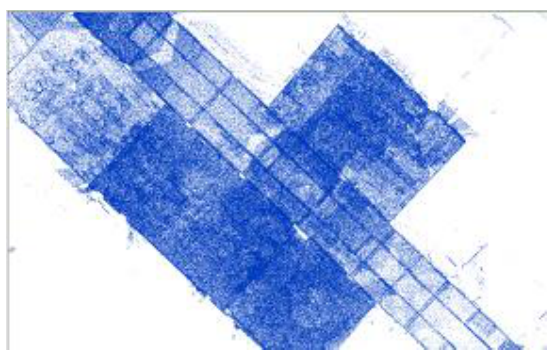
Figure 7: point cloud data collected by Leica scanstation C10